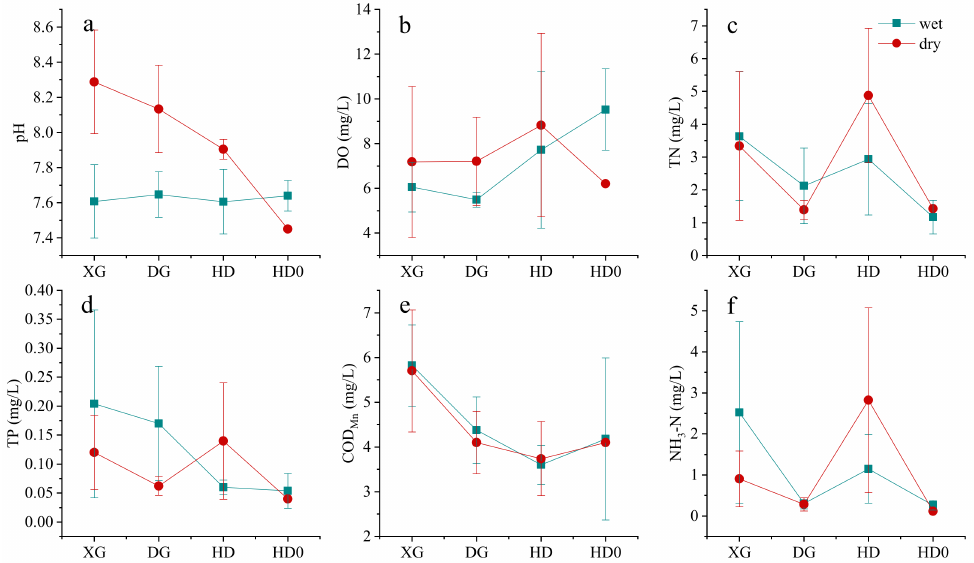
Figure 5. Differences in pH ( a ), DO ( b ), TN ( c ), TP ( d ), COD Mn ( e ) and NH 3 -N ( f ) of the inlet rivers in Baoan Lake during the dry and wet seasons. In this figure, XG, DG, HD, and HD0 repre- sent the Baoanxi Gang, Baoandong Gang, Huandiqiao Gang, and upstream points of Huandiqiao Gang, respectively.